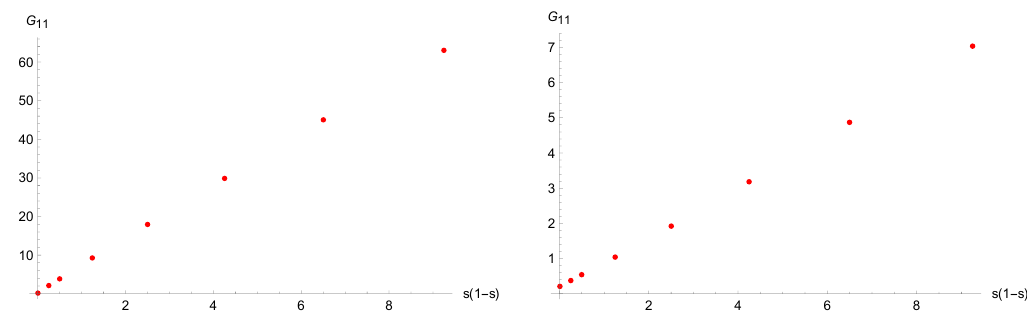
Figure 9 . Left: the 1 (cid:0) 1 correlator with m 2 = 1 ; B = 1 as a function of s (1 (cid:0) s ) (irrelevant operator). Right: the relevant case m 2 = (cid:0) 0 : 1, B = 1. They both resemble the analogous correlators of the meron wormhole and AdS 2 , in that they acquire a small (cid:12)nite minimum in the IR and blow up in the